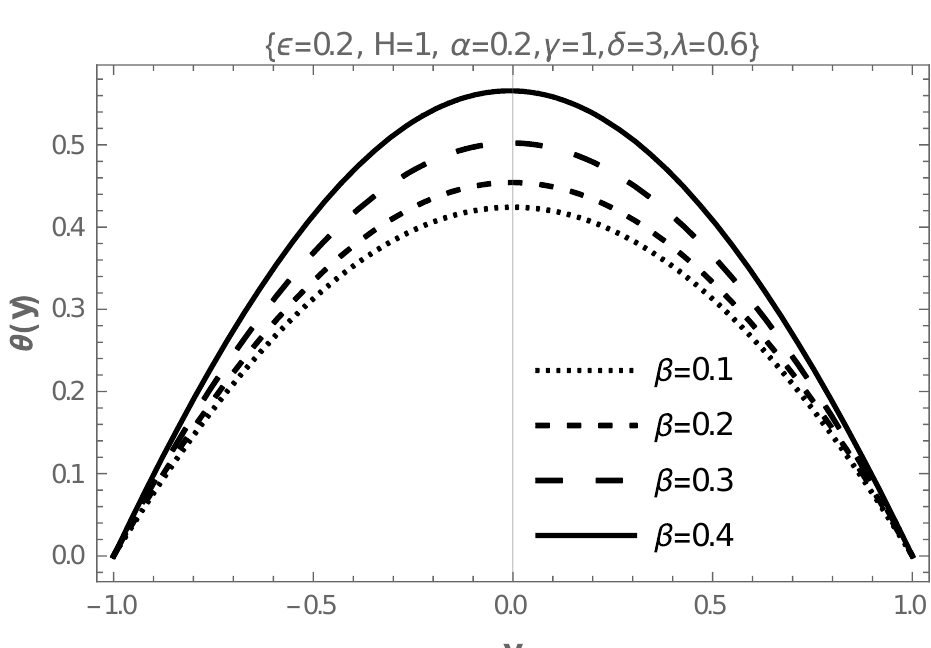
Figure 4. Velocity profile with couple stress inverse parameter ( β ).